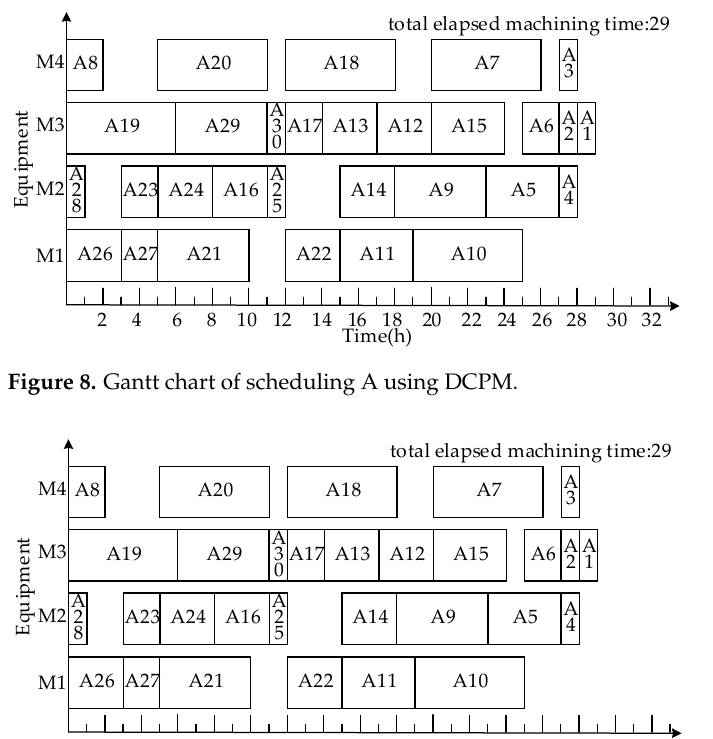
Figure 8. Gantt chart of scheduling A using DCPM.